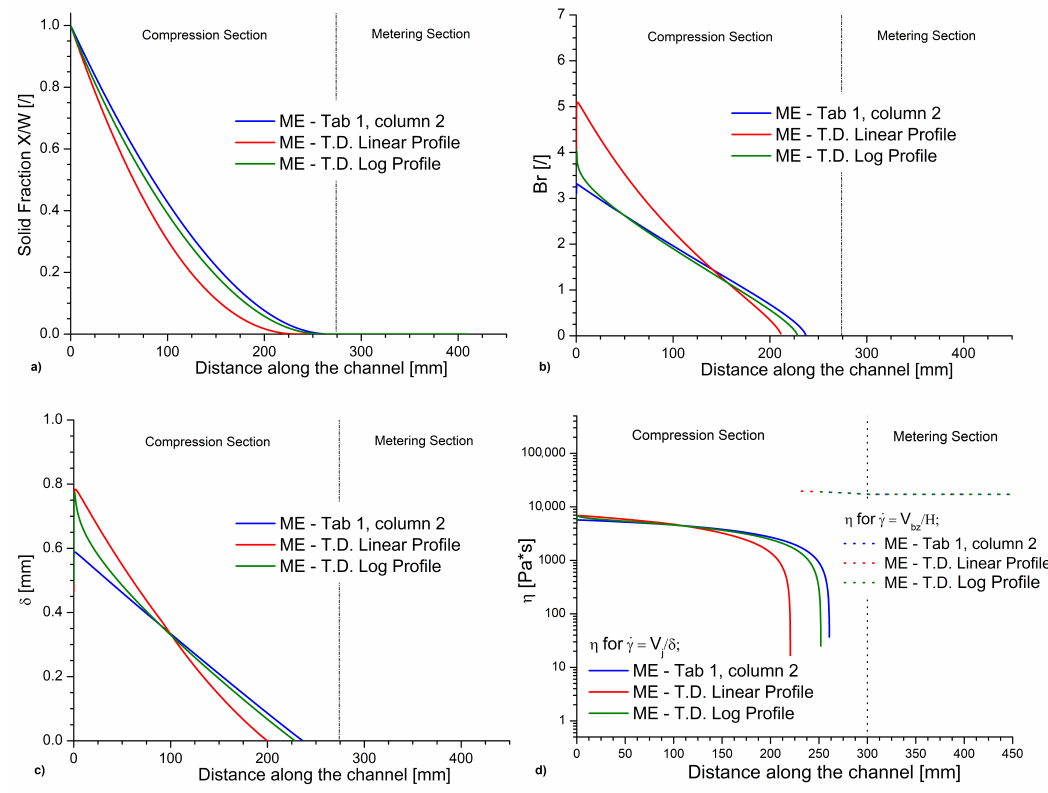
Figure 14. For the micro-extrusion settings in Figure 13: ( a ) melt profile; ( b ) the variation of the Brinkman number; ( c ) the melt layer thickness; and ( d ) the viscosity. Blue lines are for the reference case in Table 1 with constant physicochemical properties. T.D., temperature